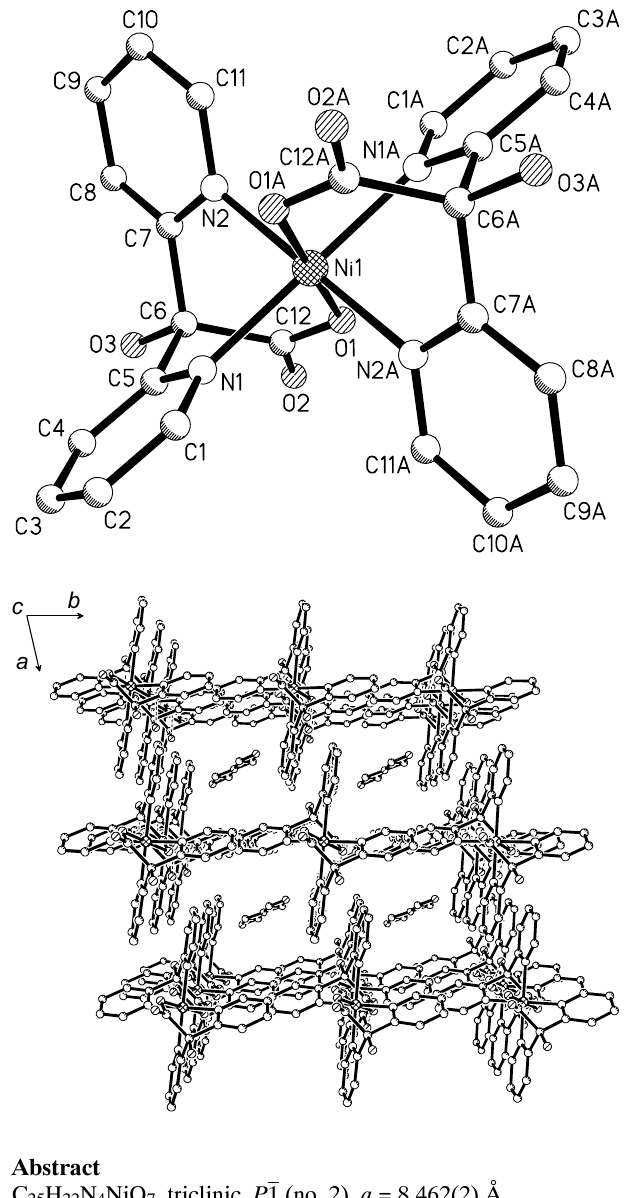
b = 8.514(2) Å , c = 10.467(2) Å , (cid:1) = 79.823(4)°, (cid:2) = 74.813(4)°, (cid:3) = 76.791(4)°, V = 703.1 Å 3 , Z = 1, R gt ( F ) = 0.045, wR ref ( F 2 ) = 0.144, T = 296 K .